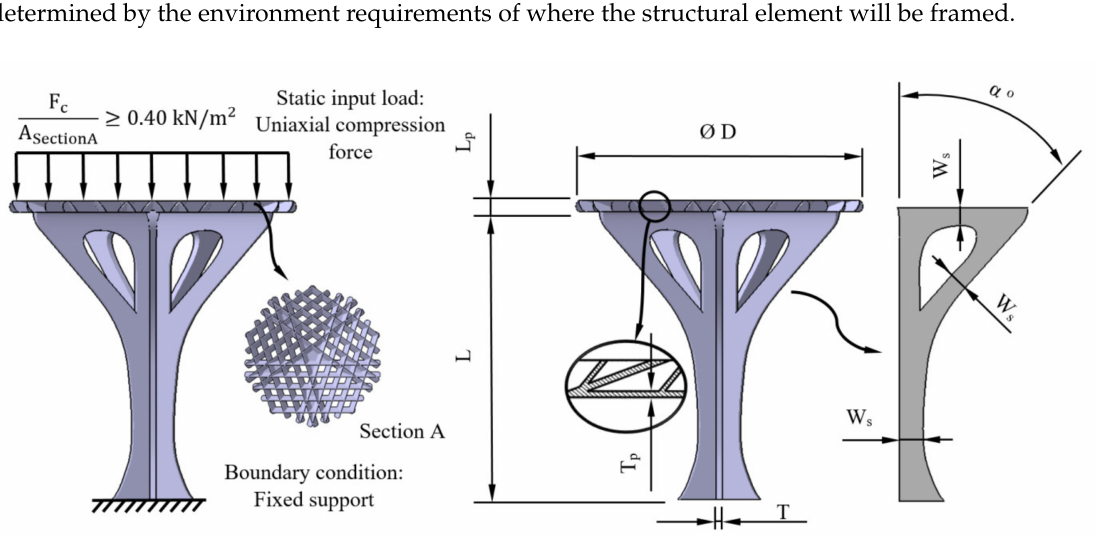
Figure 2. Boundary conditions, load definition and main geometrical parameters of the plastic structural